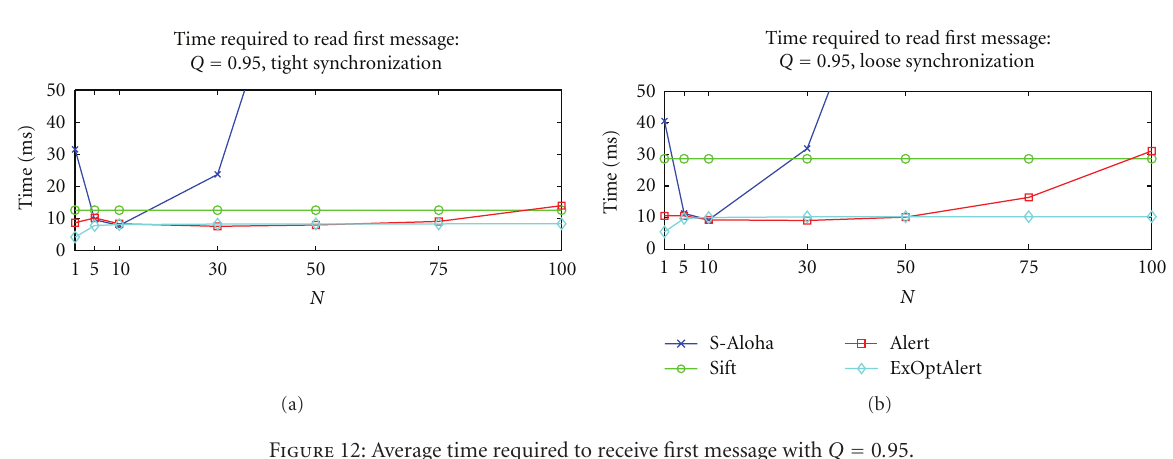
Figure 12: Average time required to receive first message with Q = 0 . 95.